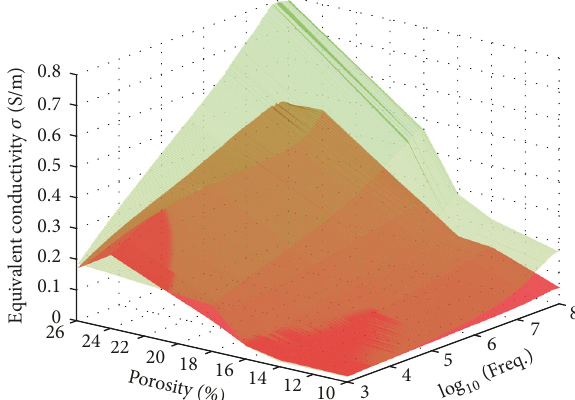
Figure 7: Surface plot of conductivity, measured parallel (in green) and normal (in red) to the bedding, versus porosity and frequency in 6 brine saturated artificial shale samples.